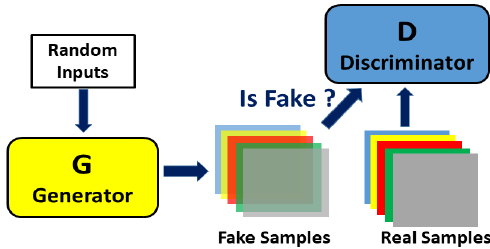
Figure 7. Functional components of a vanilla GAN.